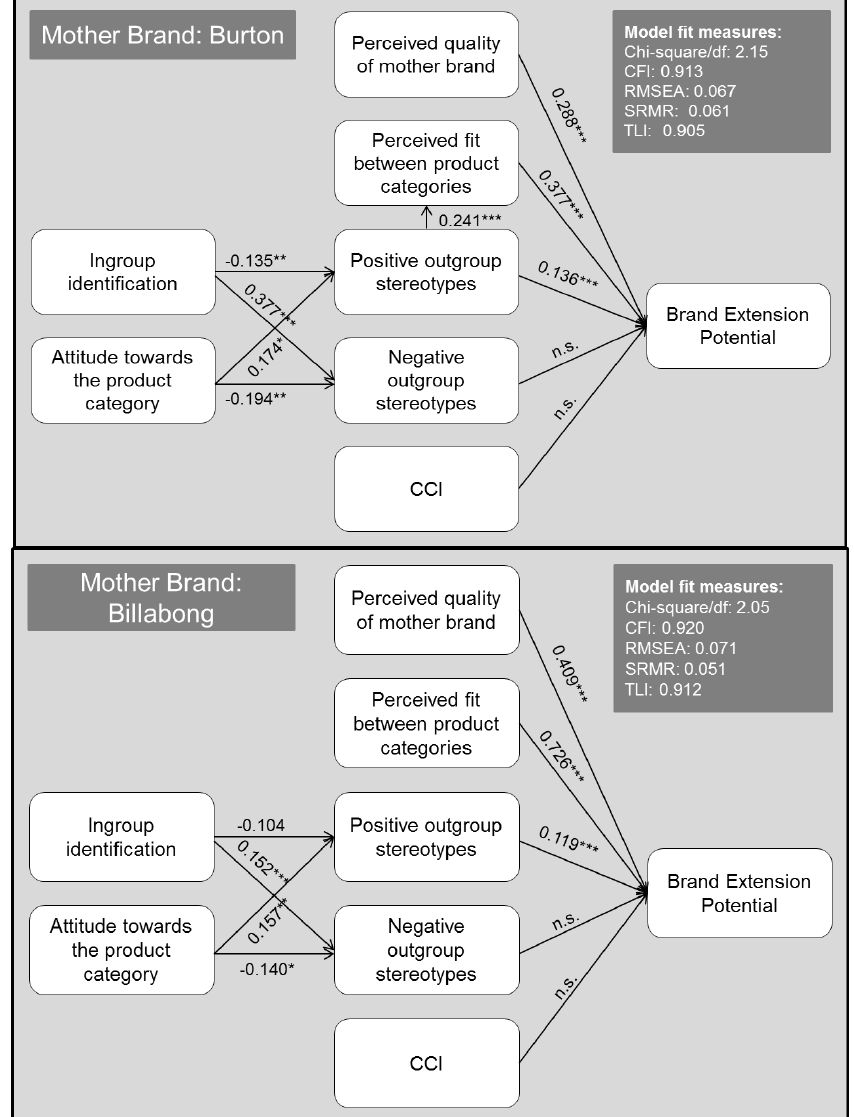
Fig. 2. Structural equation models with path coefficients and model fit